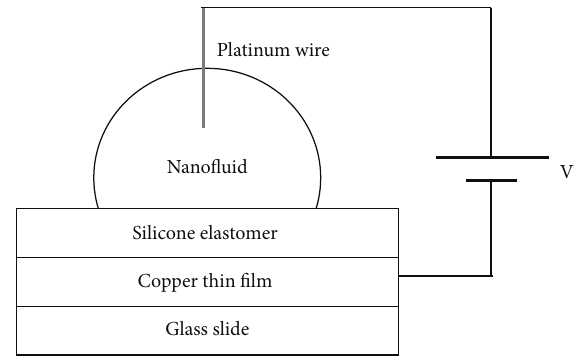
Figure 3: Schematic diagram of a planar electrowetting set-up for the actuation of a nanofluid